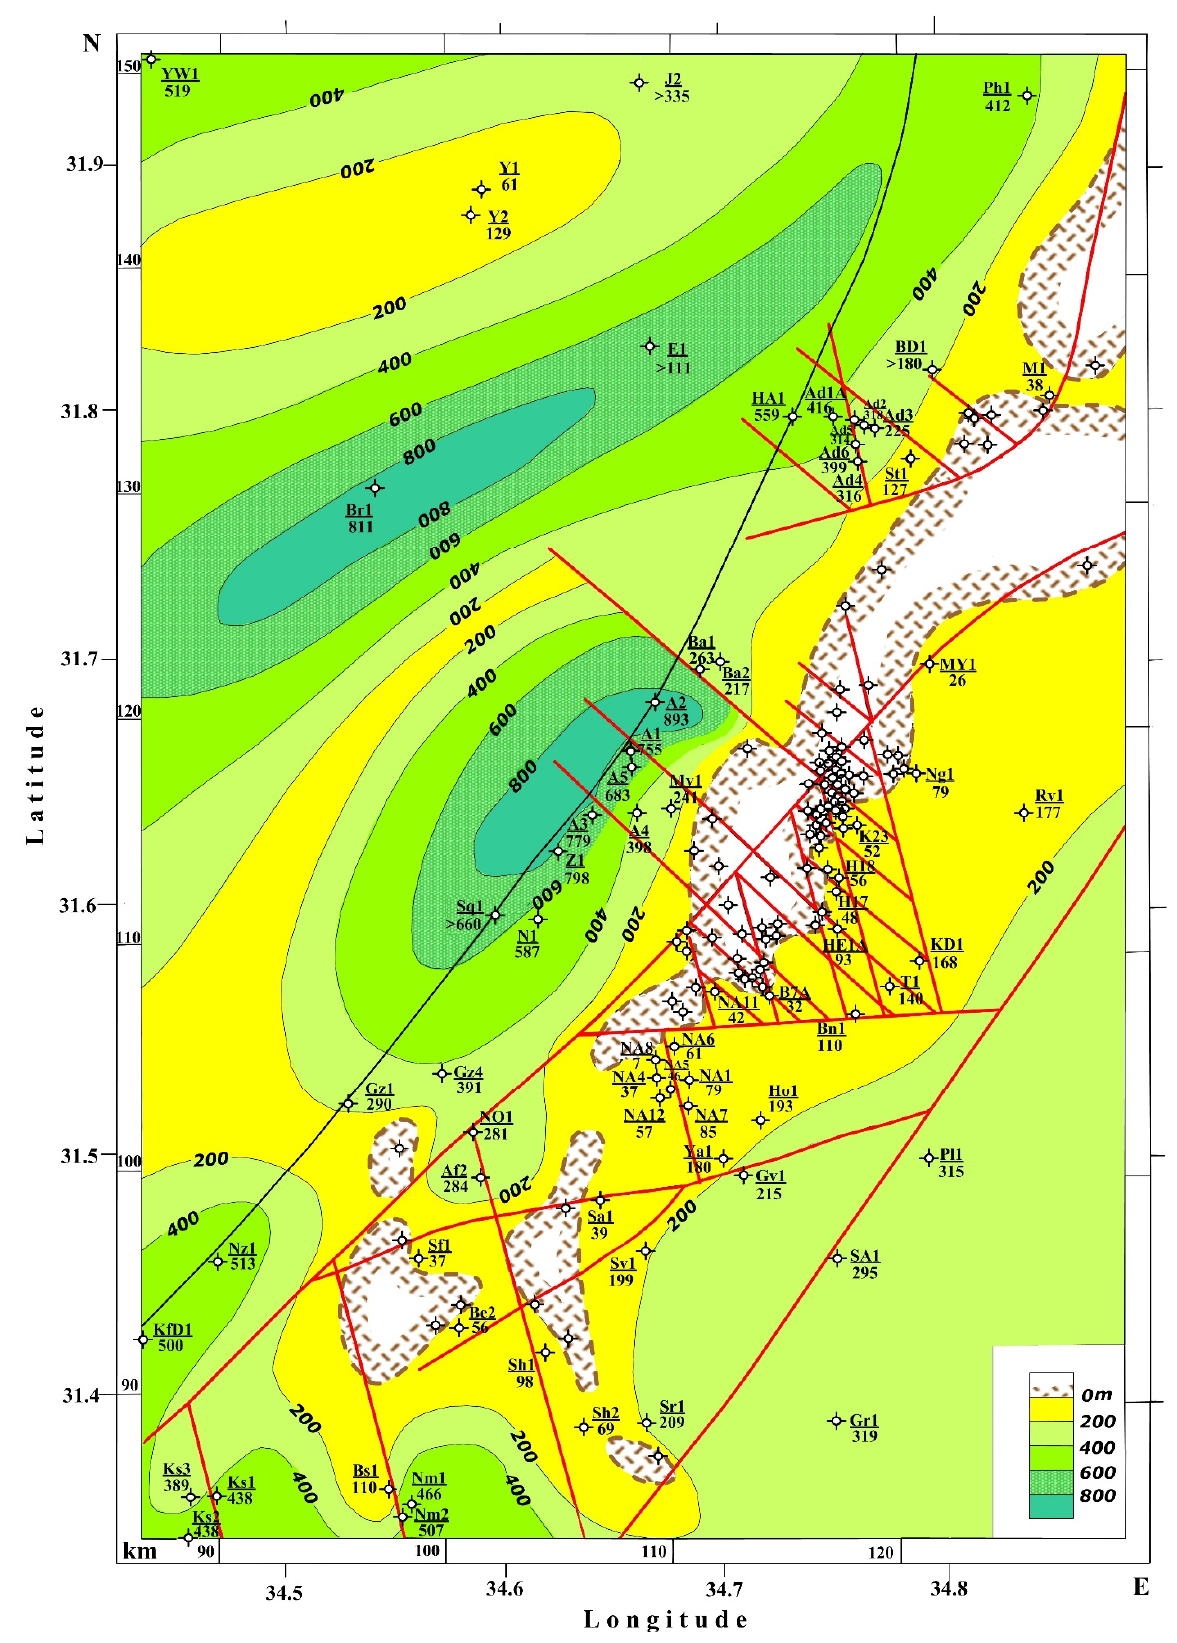
Figure 3. Paleogene structural–paleogeographic map of the Heletz–Ashdod oil field and adjacent areas. Borehole abbreviations: see captions for Figure 2.